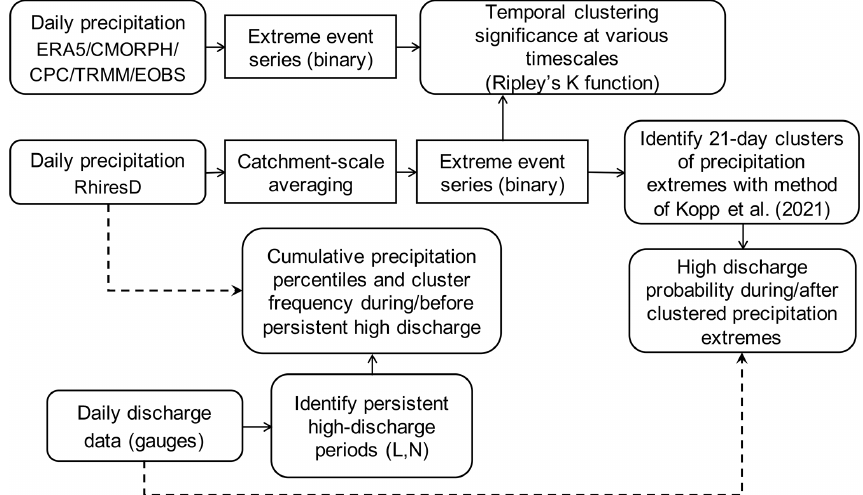
Figure A1. Summary of the data and methodology adopted in this